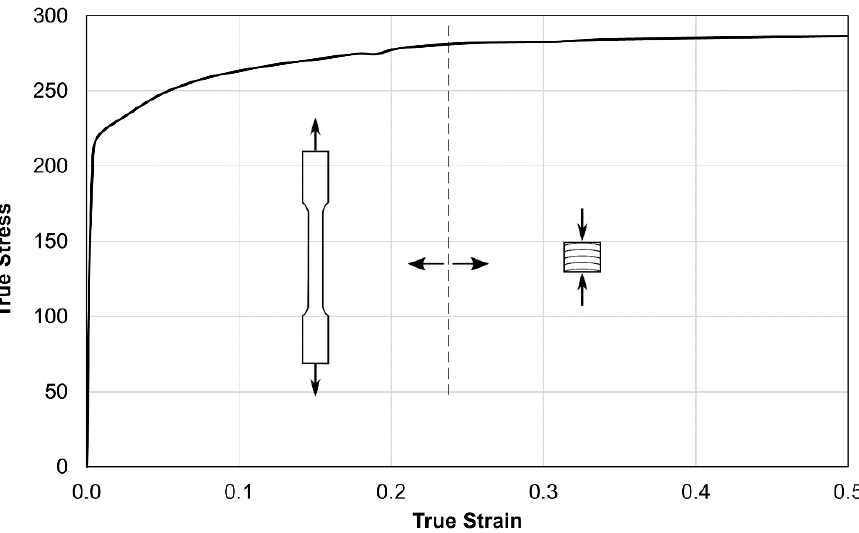
Figure 1. Flow curve of the aluminum AA6063T6 tubes (adapted from [9]).